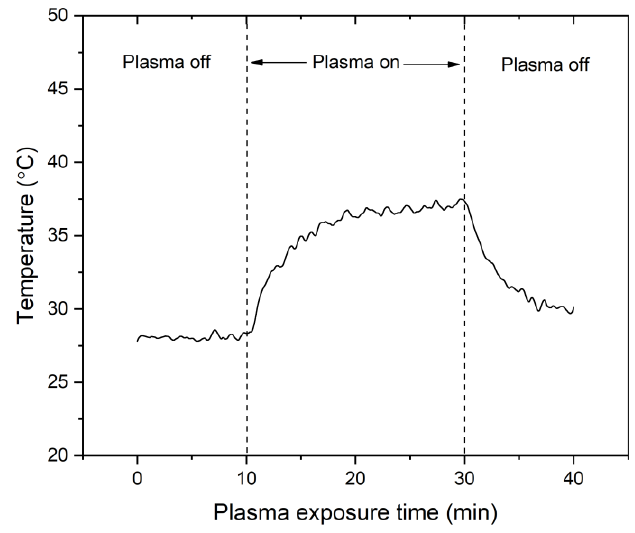
Figure 3. The temperature on the probe as a function of the plasma exposure time.